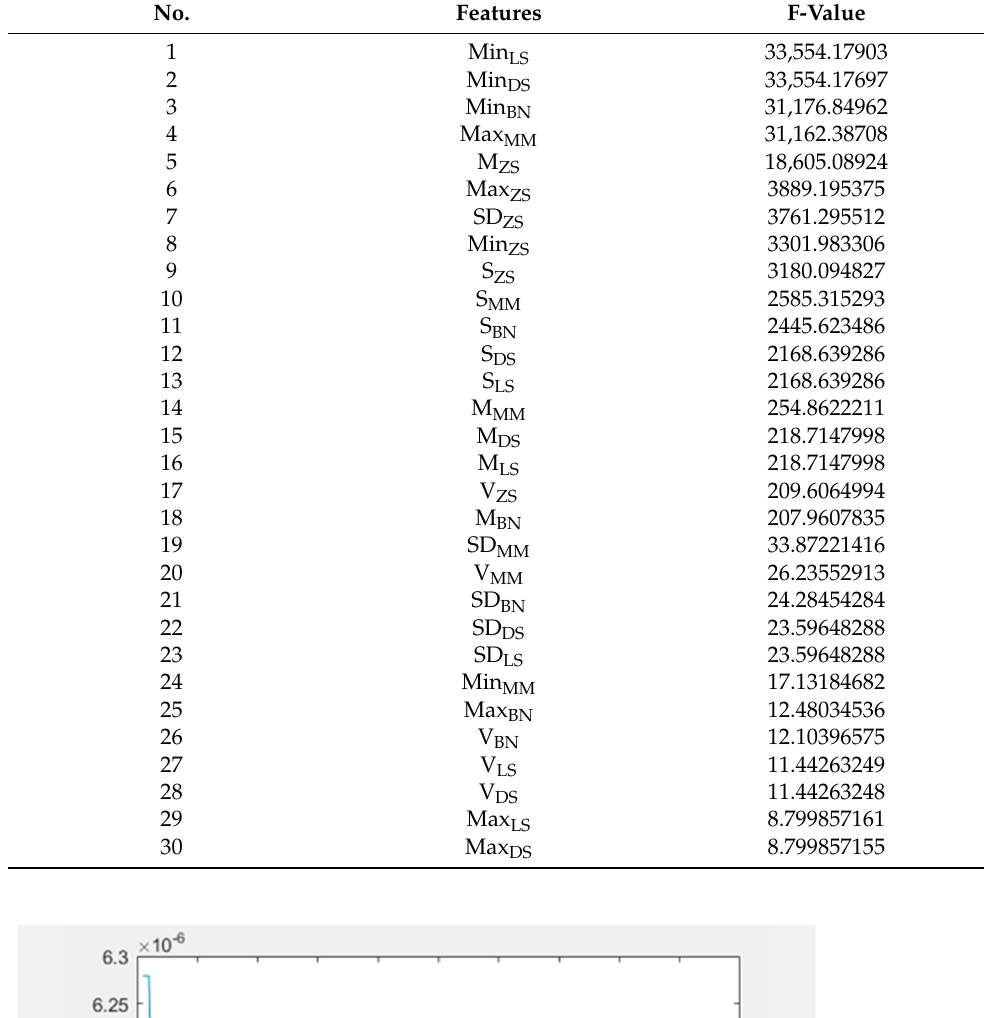
Table 5. F-value for all features.